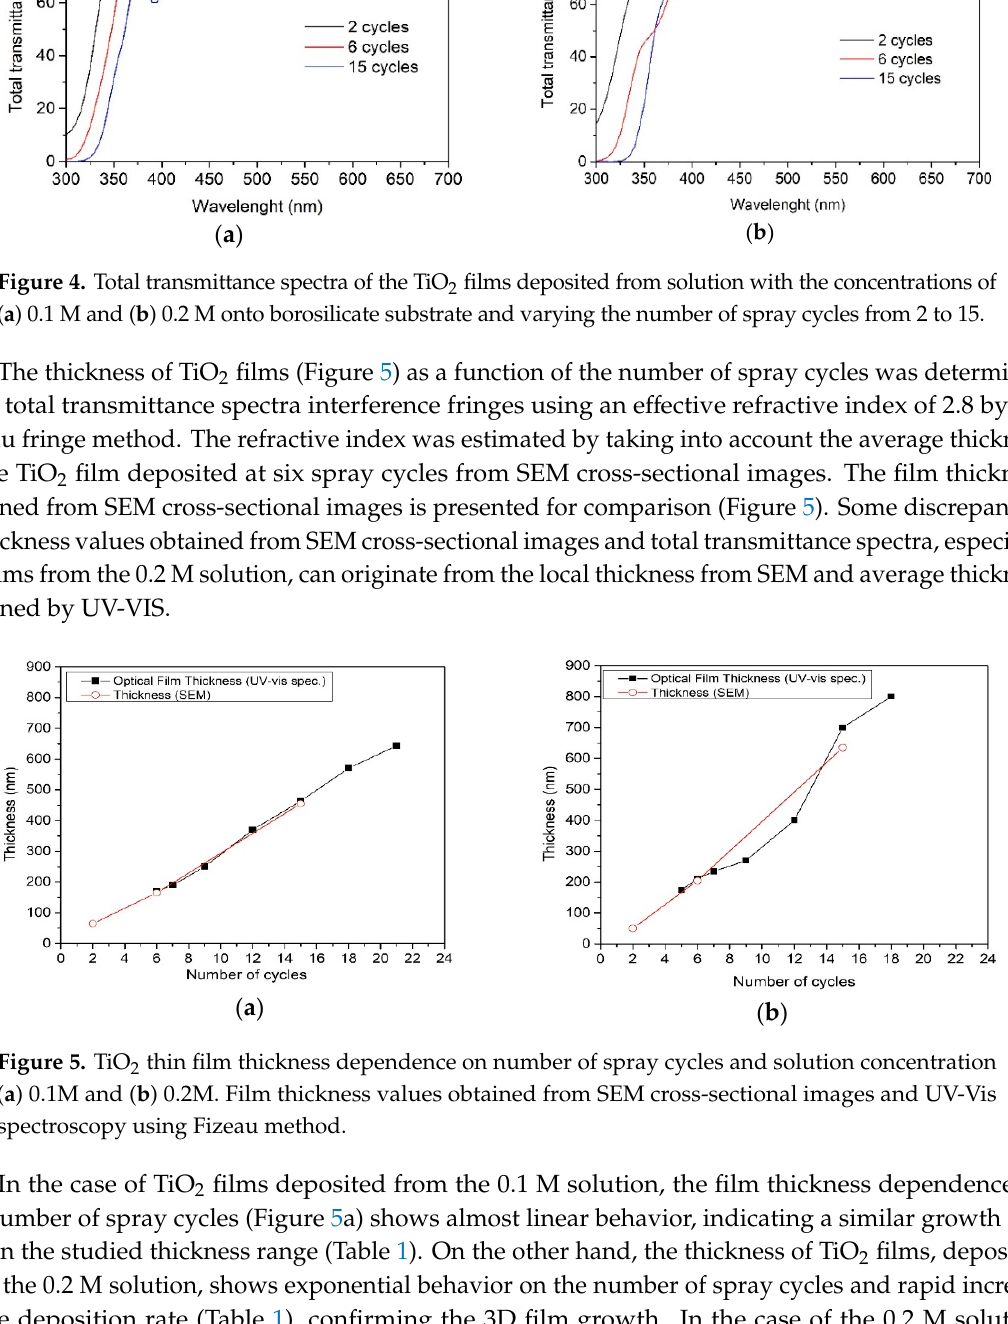
Figure 4. Total transmittance spectra of the TiO 2 films deposited from solution with the concentrations of ( a ) 0.1 M and ( b ) 0.2 M onto borosilicate substrate and varying the number of spray cycles from 2 to 15.